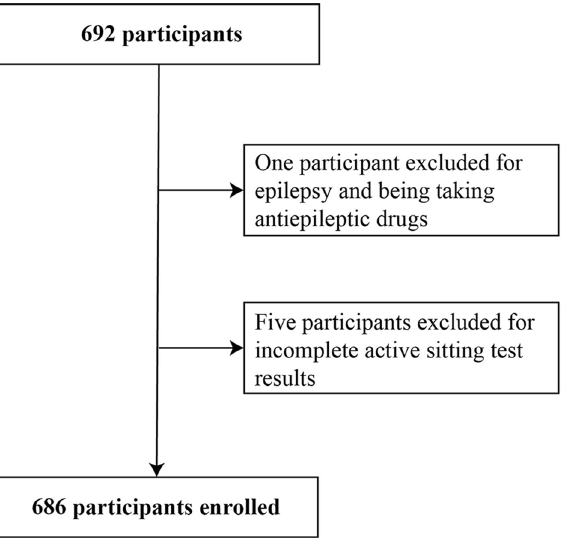
Figure 1. Flow chart of enrolling participants. Among the 692 participants, 1 was excluded for epilepsy and taking antiepileptic drugs, and another five were excluded for incomplete active sitting test results. 686 participants were finally recruited in the